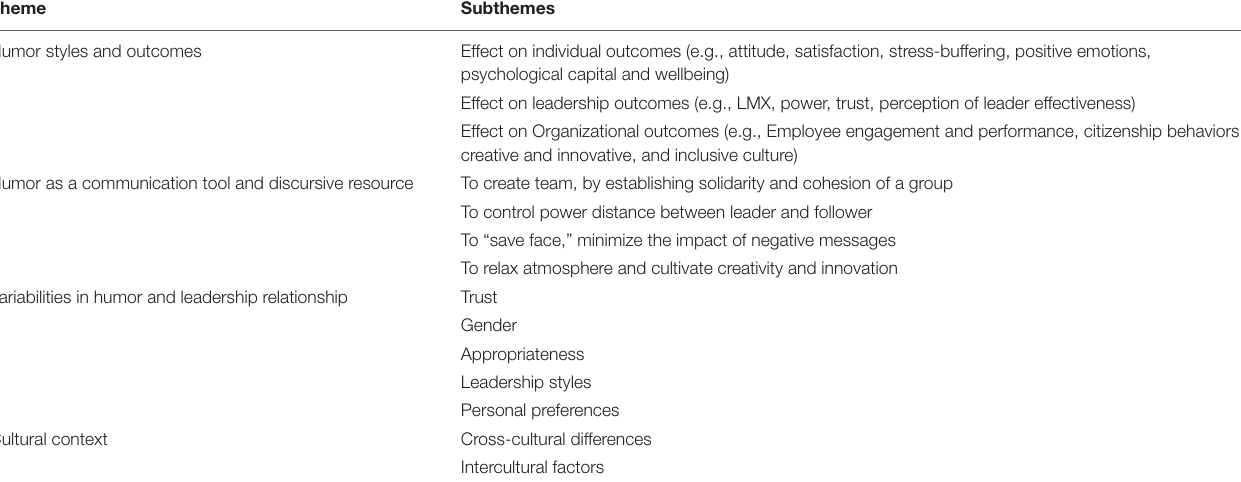
TABLE 4 | Summary of themes and subthemes.